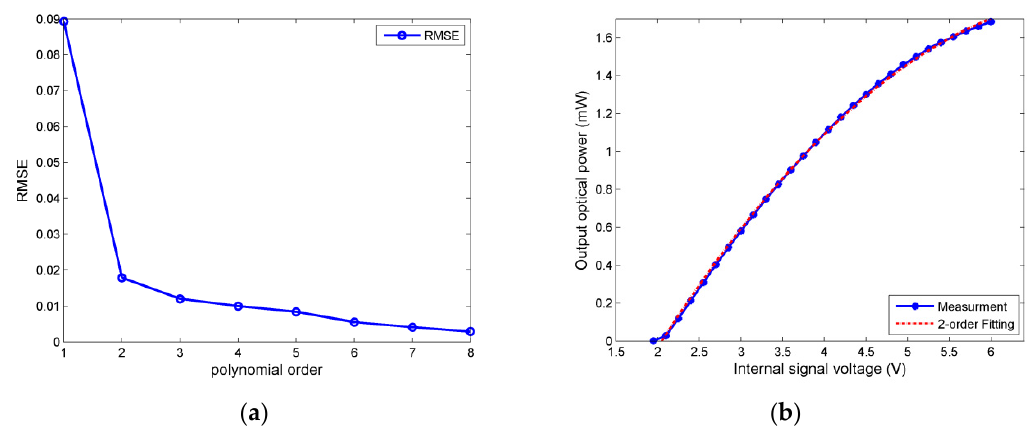
Figure 3. Measured results and polynomial fitting: ( a ) root mean squared error (RMSE) comparison; ( b ) 2 ‐ order fitting curves.